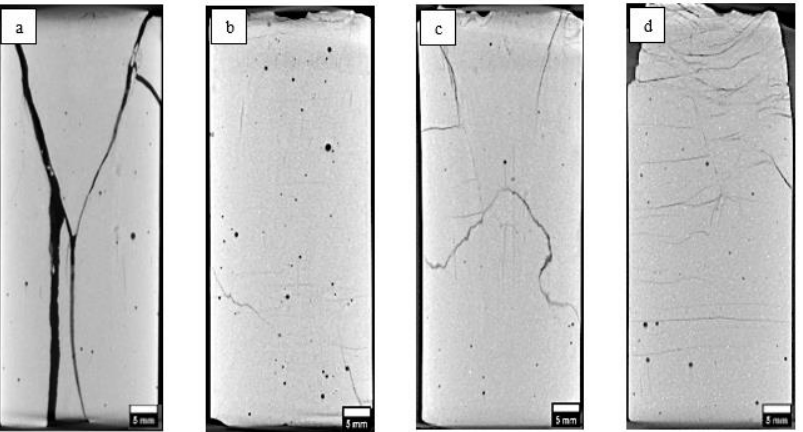
Figure 8. CT scans of cement cores after failure under triaxial testing at a confining pressure of 13.7 MPa and 90 ◦ C: ( a ) neat Class-H cement showing the failure in comparison to the others; ( b ) 5% ferrierite-added cement; ( c ) 15% ferrierite-added cement; ( d ) 30% ferrierite-added